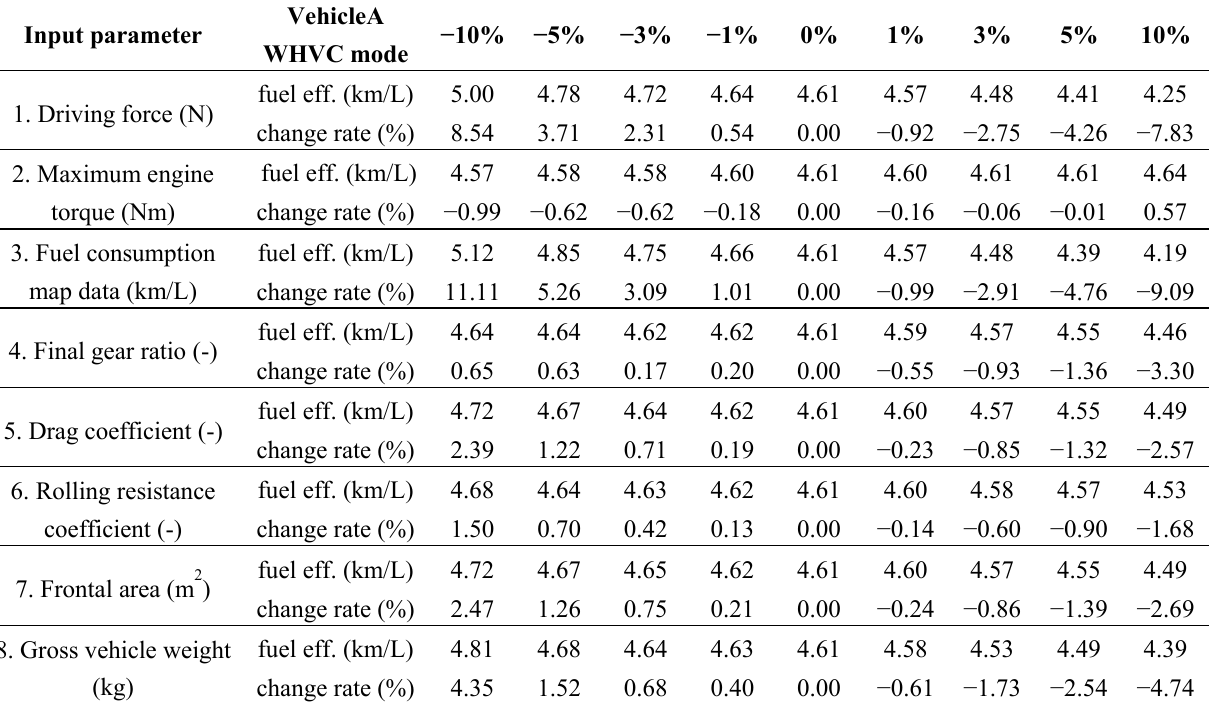
Table 10. Relative changes of the predicted fuel efficiency results compared to baseline case—case 2. Input parameter